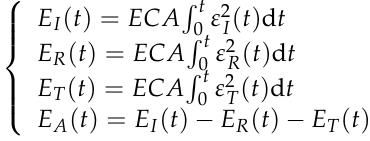
Figure 3. Change in compressive strength of rock samples.